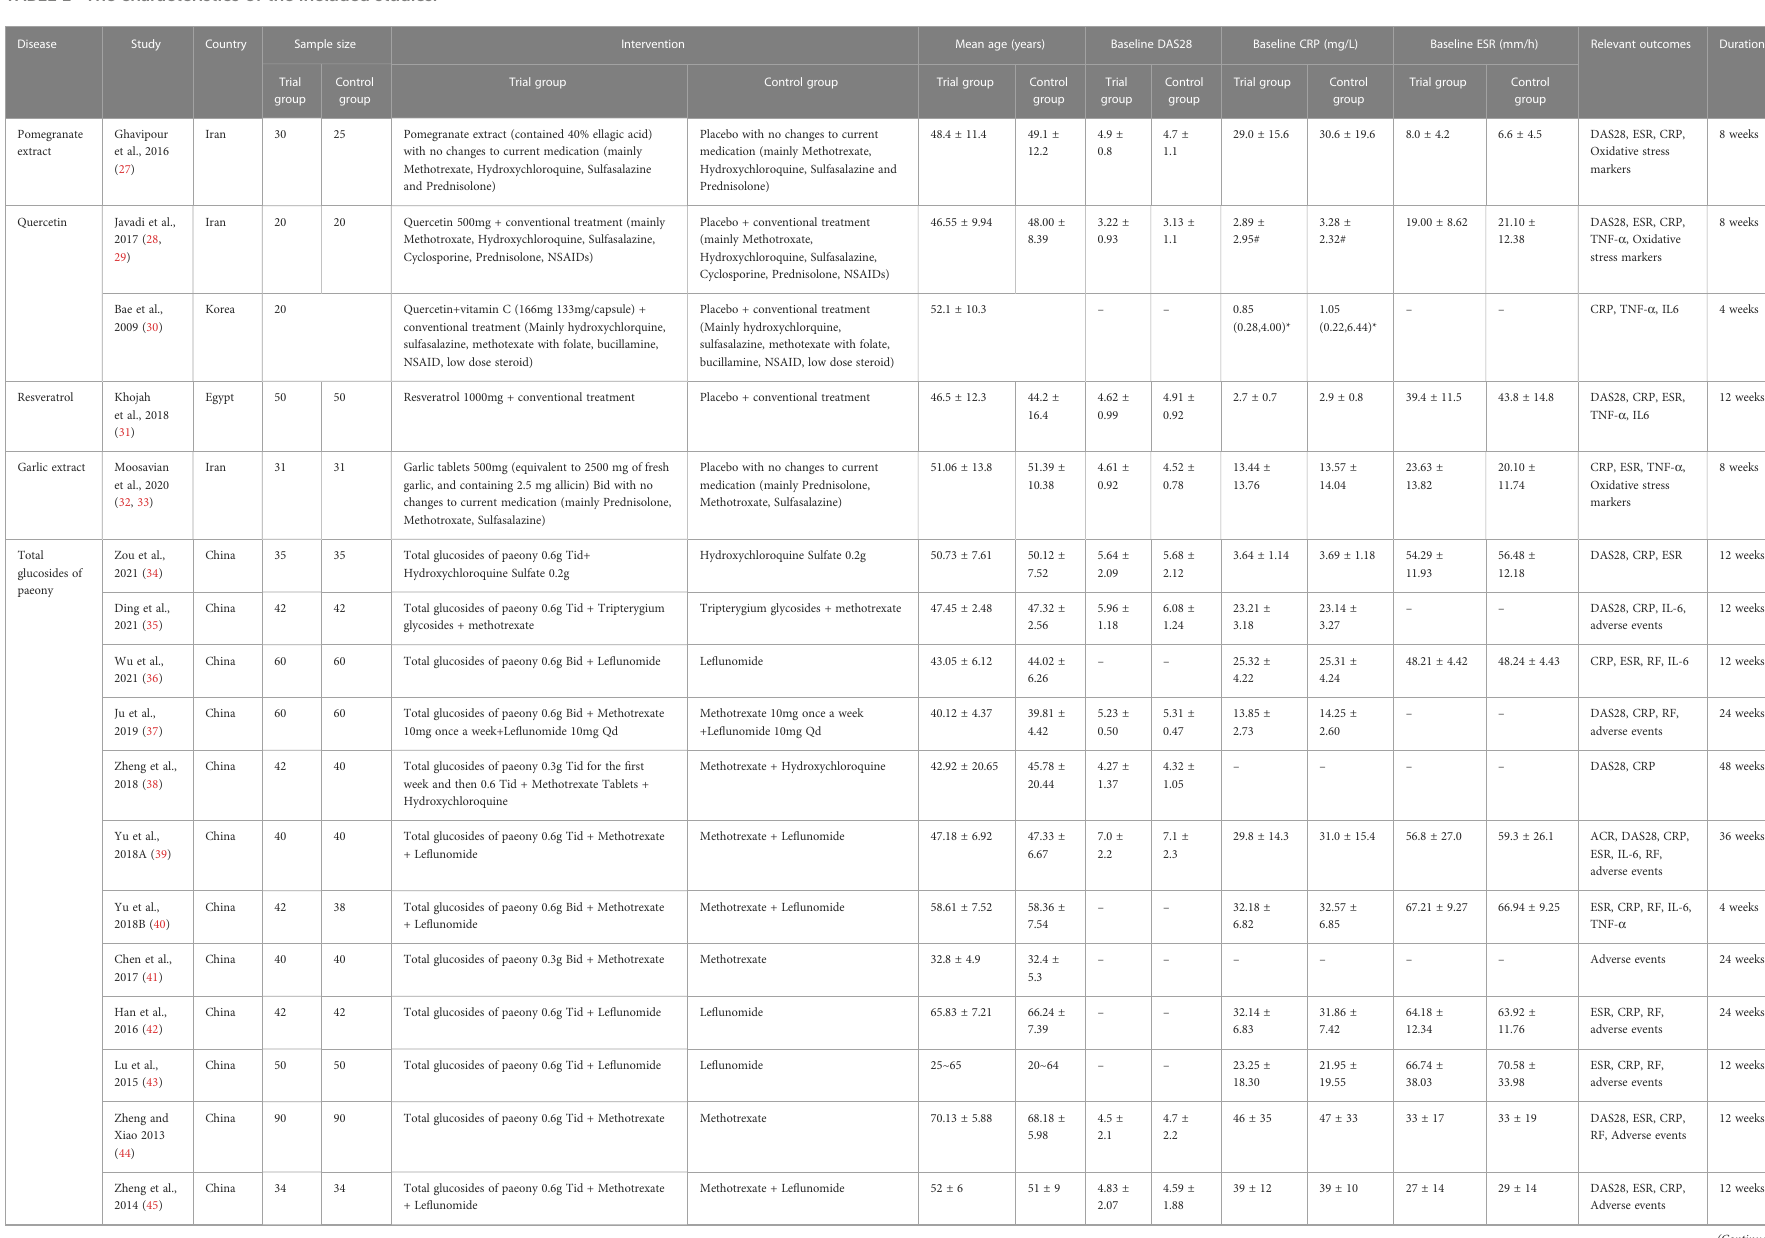
TABLE 1 The characteristics of the included